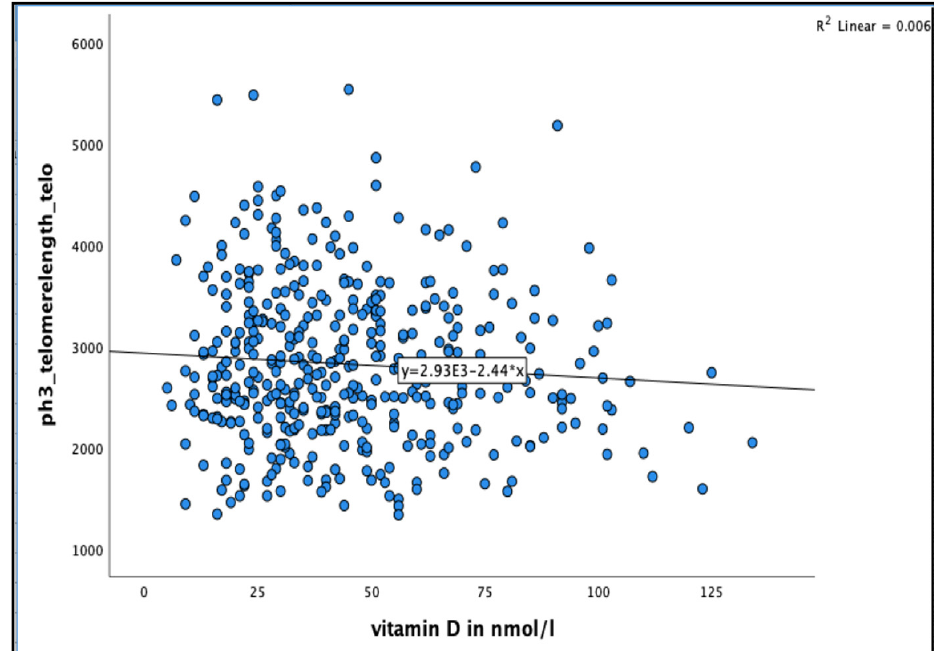
Figure 4. The association between 25(OH)D concentration and Telomere length at 36 months in the Newcastle 85+ Study. Table 6. Association between different 25(OH)D cut-offs and Telomere length at 36 months.